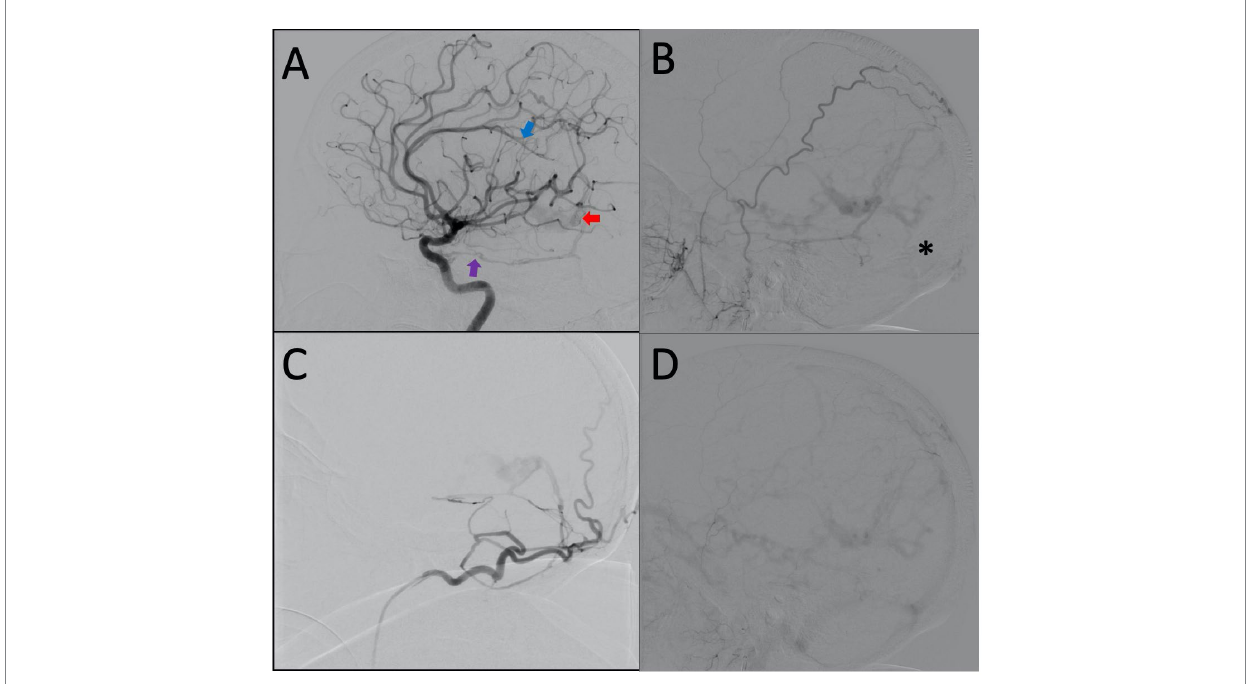
FIGURE 2 (A) Lateral projection of the right ICA demonstrating early shunting from the tentorial branch of the MHT (purple arrow) and distal ACA (blue arrow) filling the dilated vein of Galen (red arrow). (B) Lateral projection of the right ECA showing retrograde venous drainage and occlusion of the straight sinus (black asterisk). (C) Lateral projection of the right occipital artery. (D) Lateral projection of right ECA, late venous phase, demonstrating generalized venous